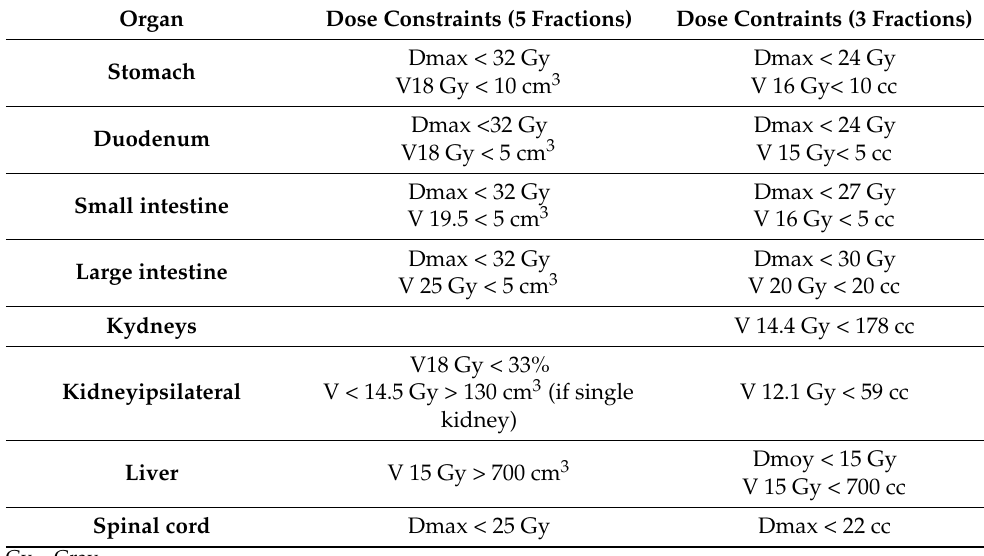
Table 1. Organ at risk dose